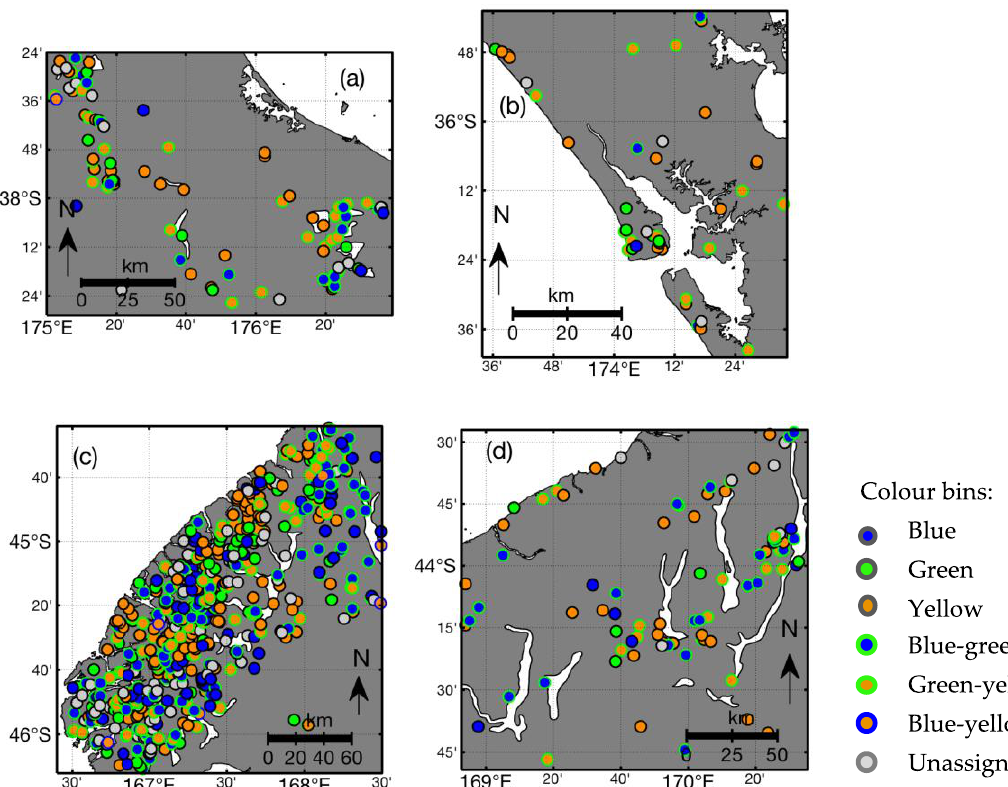
Figure 12. Geographic distribution of lakes coloured by colour bins according to Table 1 in four areas. Placement of the areas shown in maps ( a – d ) are shown in Figure 5.